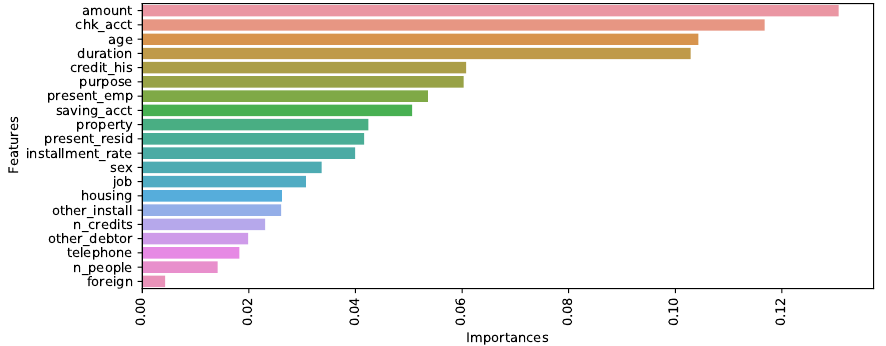
Figure 6. The importance of the variables in the random forest recursive feature elimination approach. Importance was measured via the mean decrease in the Gini index.